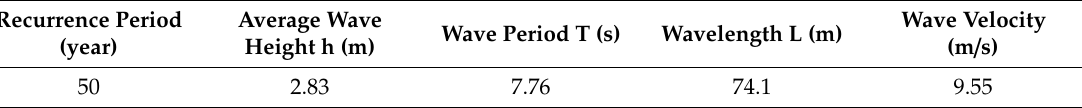
Table 1. Wave elements of